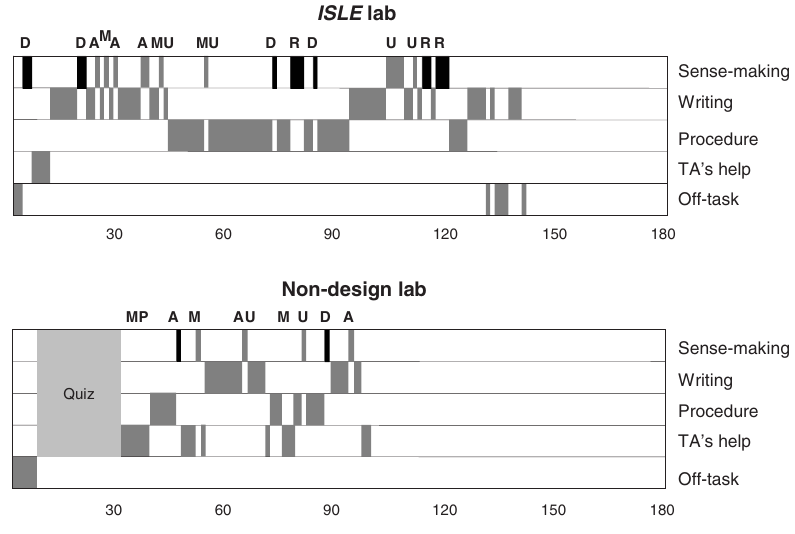
FIG. 3. Time lines for randomly se- lected groups of students in different types of labs. Black color bars indicate episodes of student sense-making that were not prompted by a write-up or a TA. Gray sense-making episodes indi- cate that student activity was prompted by a TA’s question or by a question in the lab write-up. Sense-making subcod- ing reflects the scientific abilities de- scribed in